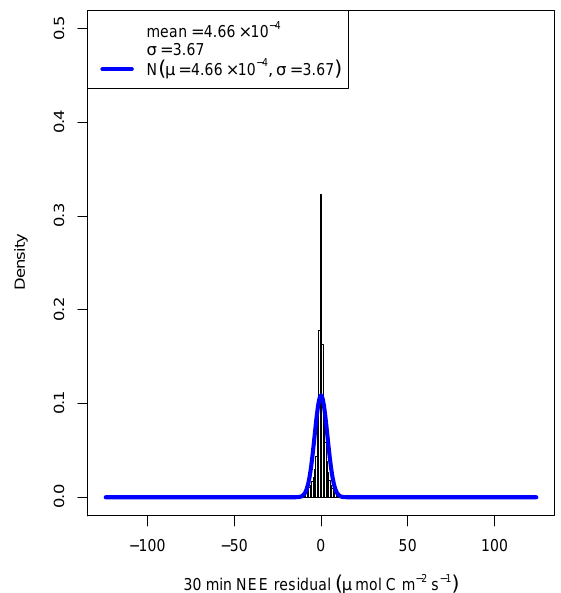
Fig. 5. Histogram of VPRM annual integrated NEE residuals, PFT– all-data VPRM parameters. These are the residuals in Fig. 4 inte- grated by site year. The residuals are calculated as ((annual inte- grated observed NEE, non-gap-filled) minus (VPRM annual inte- grated